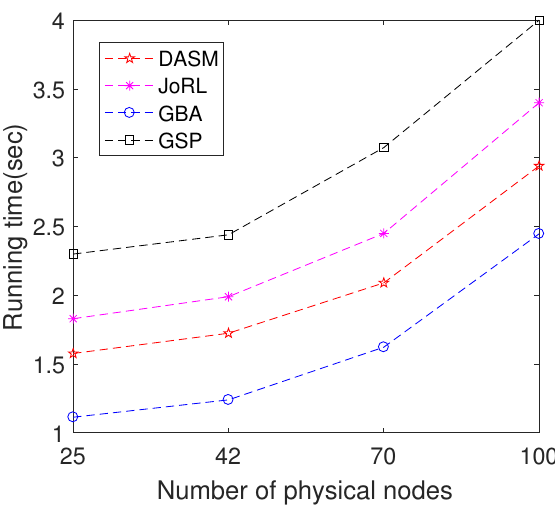
Figure 12. Algorithm running